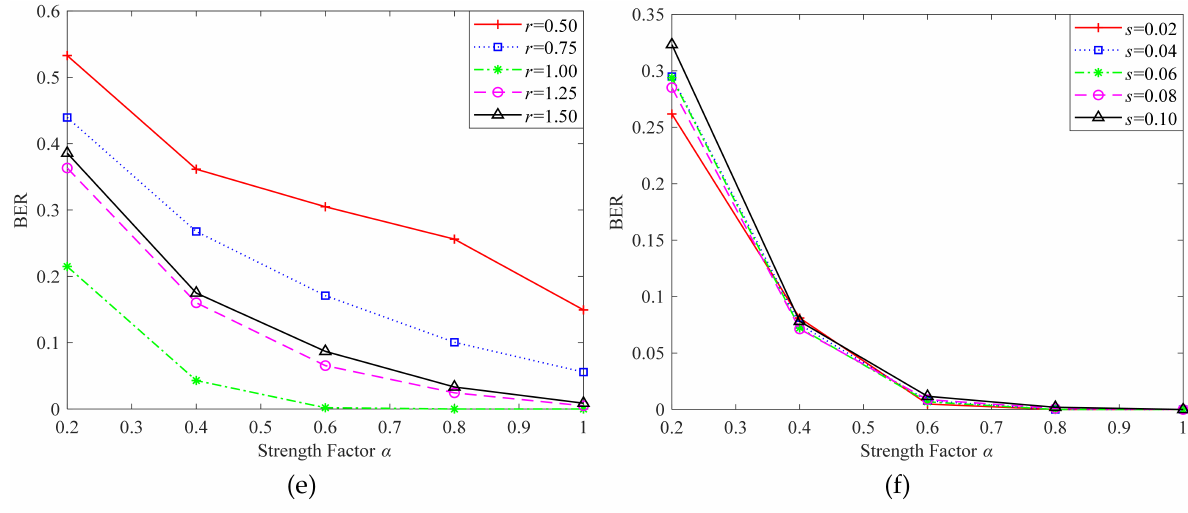
Figure 8. BER curves under different attacks: ( a ) JPEG compression, ( b ) sharpening, ( c ) cropping, ( d ) Gaussian noise, ( e ) scaling, and ( f ) salt-and-pepper noise.